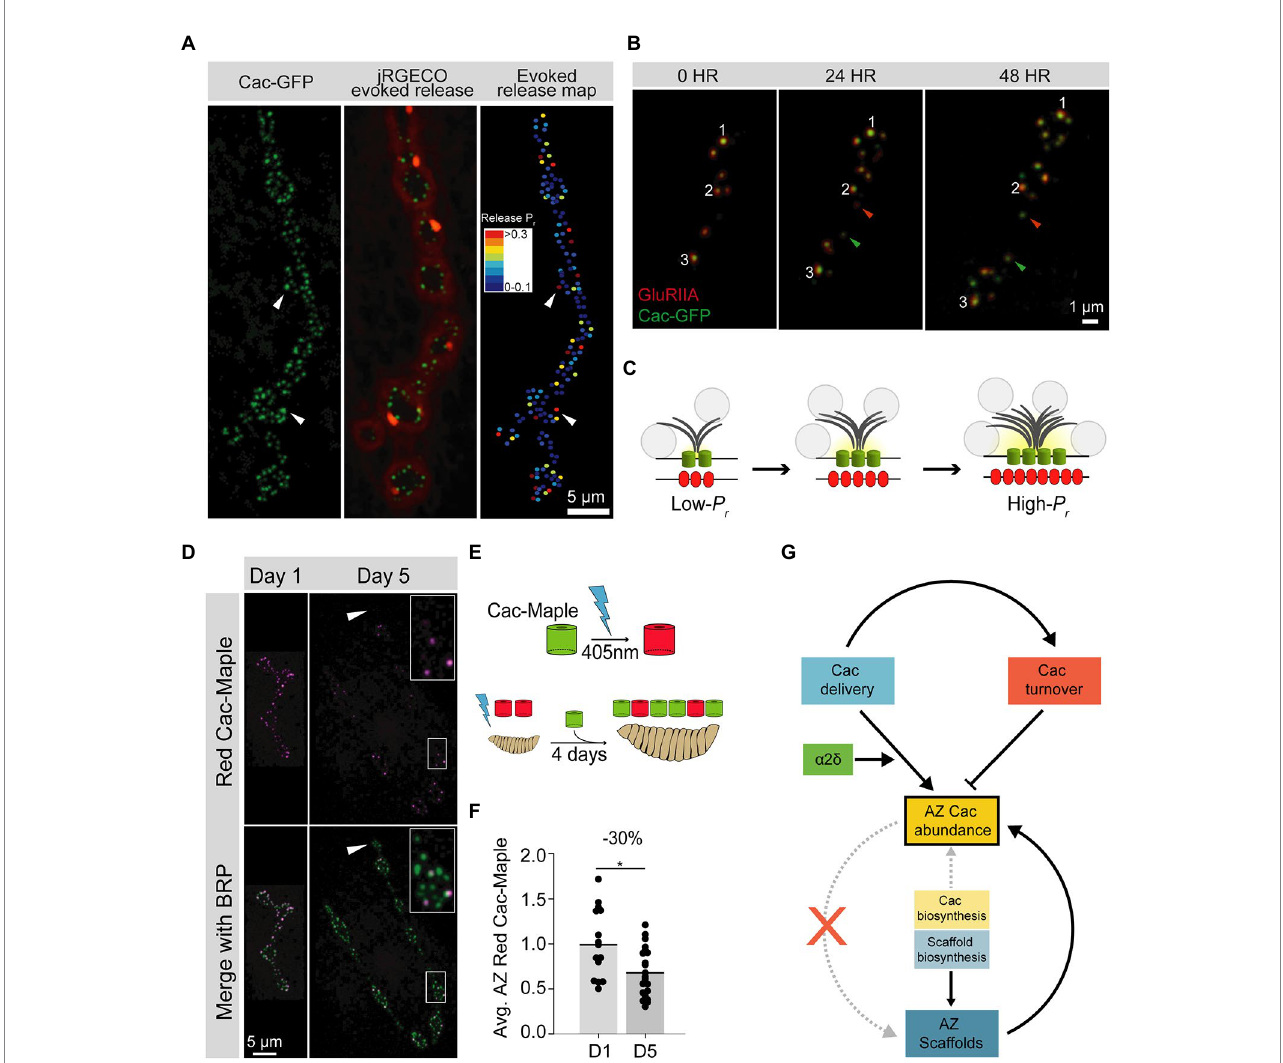
FIGURE 2 Cac regulation at the Drosophila third instar larval NMJ. (A) Representative image of a Drosophila larval NMJ. AZs are marked by clusters of Cac-GFP (green), and the jRGECO calcium sensor (red) is tethered to the postsynaptic membrane and indicates evoked release events at individual AZs. An evoked release heat map (right); generated from videos of jRGECO responses following a series of individual APs indicates P r for each AZ, with high- P r AZs in red and low- P r sites in blue. (B) Sequential intravital imaging of a growing NMJ in an intact, anesthetized animal. Glutamate Receptor subunit GluRIIA-RFP marks postsynaptic densities and Cac-GFP marks presynaptic AZs. Arrows mark several new AZs formed after the 0-h timepoint, and white numbers track individual AZs through the image series. (C) Schematic of an AZ as it structurally and functionally matures from a young (low- P r ) site to an old (high- P r ) site through the multi-day acquisition of key components including BRP (gray), and Cac (green). Postsynaptic Glutamate Receptor abundance (red) also increases throughout maturation. SVs are marked as gray circles. (D) Representative images of Cac-Maple (magenta) and the AZ scaffold BRP (green) at